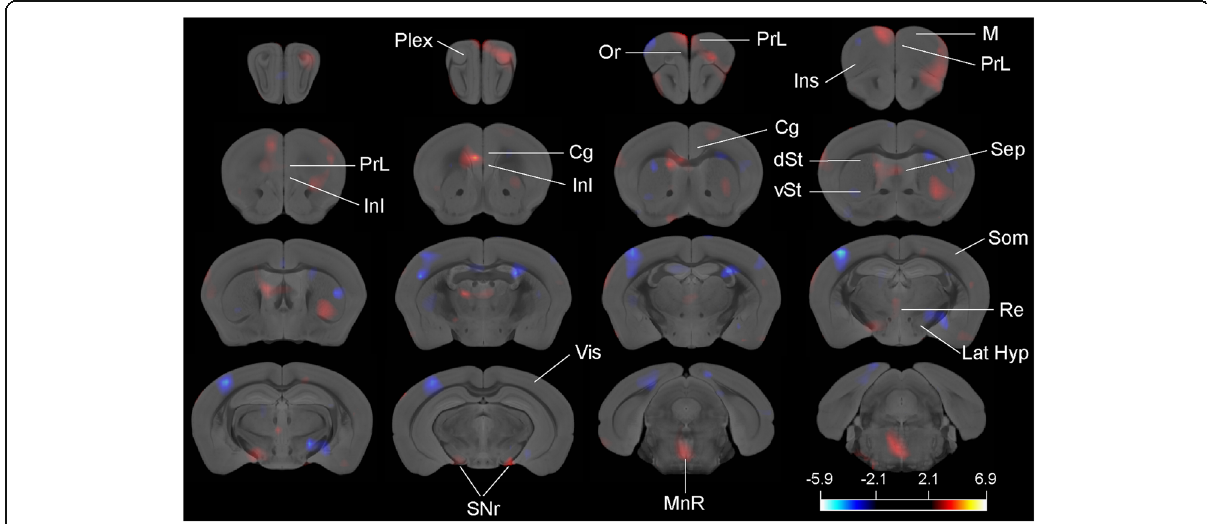
Fig. 2 [ 18 F]-F-DOPA PET scanning in control and D2 mutant animals. Red-yellow color represents a significant increase of [ 18 F]-F-DOPA incorporation in control animals and blue-white color a significant increase of [ 18 F]-F-DOPA incorporation in mutant D2 animals. t value for p < 0.05 is specified. Plex plexiform region, M motor cortex, Or orbital cortex, PrL prelimbic cortex, InL infralimbic cortex, Cg cingulate cortex, Som somatosensory cortex, Ins insular cortex, dSt dorsal striatum, vSt ventral striatum, Sep septum, Re reuniens nucleus, Lat Hyp lateral hypothalamus, Vis visual cortex, SNr substantia nigra reticulata, MnR median